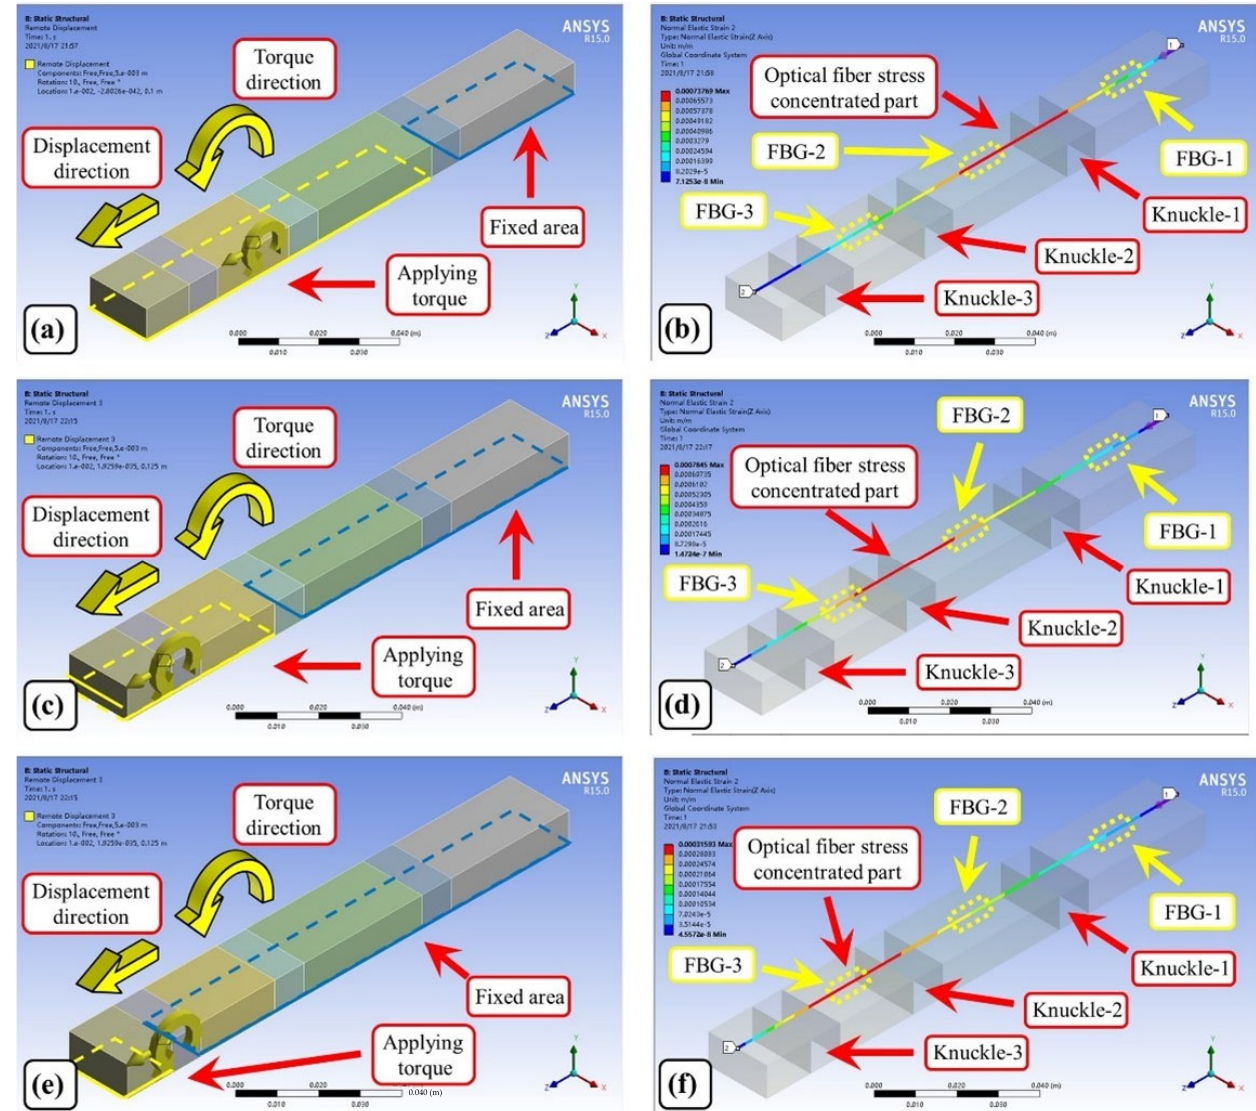
Figure 5. Force analysis of optical fiber during knuckle bending. ( a ) Knuckle ‐ 1 bending simulation; ( b ) Fiber force analysis during knuckle ‐ 1 bending; ( c ) Knuckle ‐ 2 bending simulation; ( d ) Fiber force analysis during knuckle ‐ 2 bending; ( e ) Knuckle ‐ 3 bending simulation; and ( f ) Fiber force analysis during knuckle ‐ 3 bending.